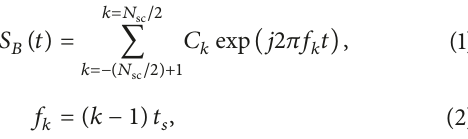
area ( ∼ 15 𝜇 m) and low-source power of VCSELs offered high coupling efficiency for MMF links